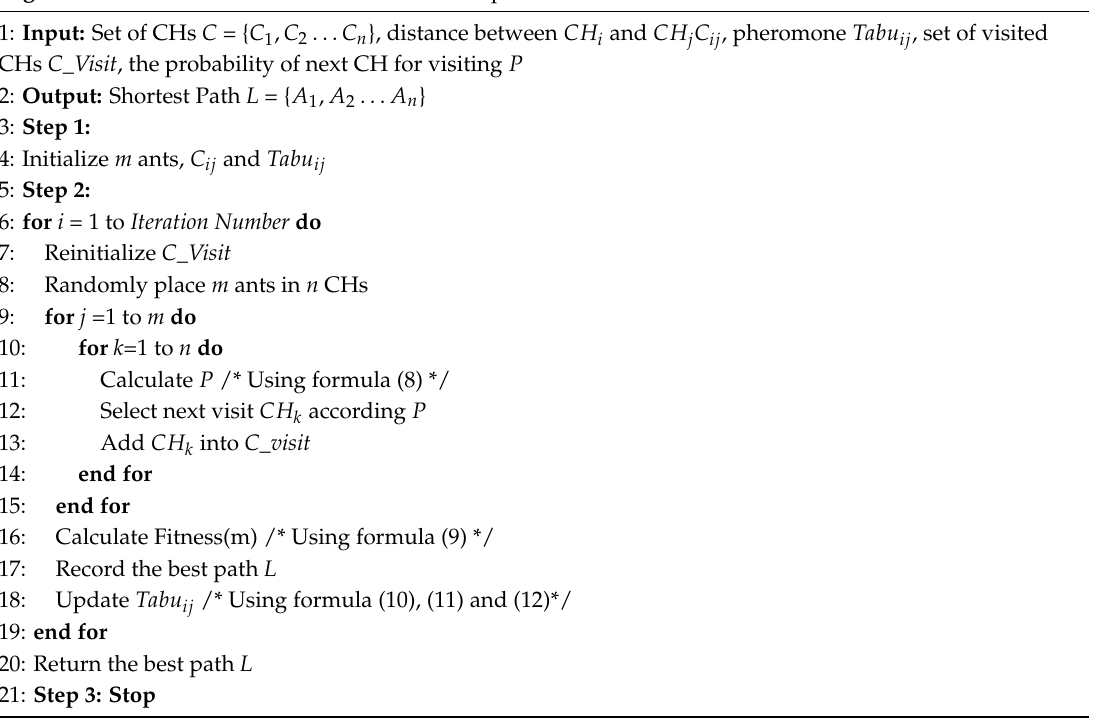
Algorithm 1 : Pseudocode of ACO-based shortest path